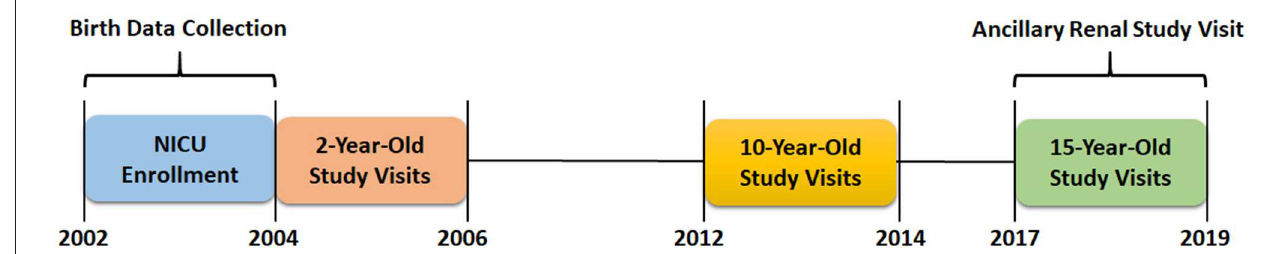
FIGURE 1 | ELGAN study data collection